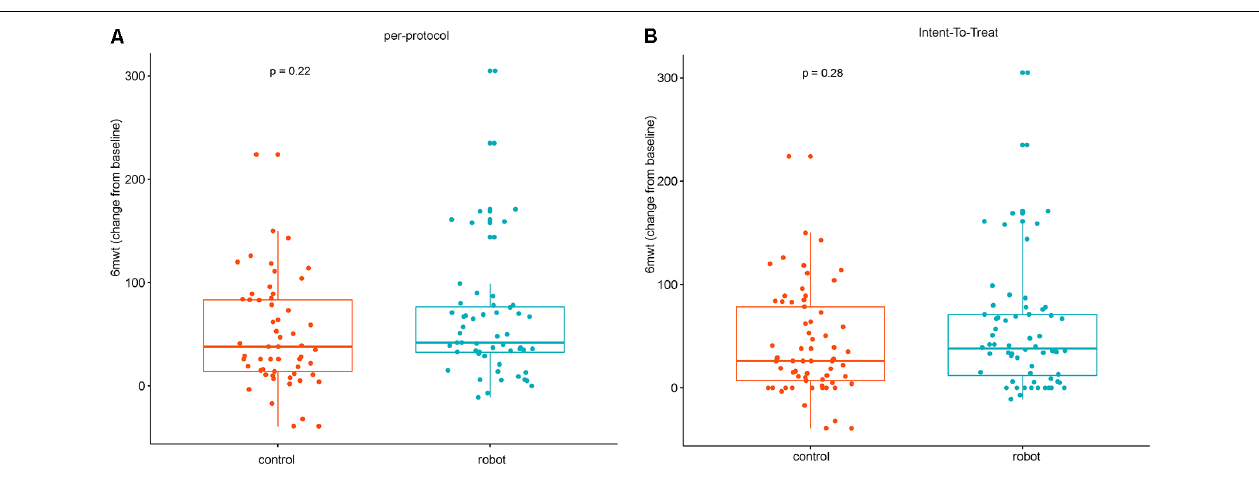
Frontiers in Aging Neuroscience |